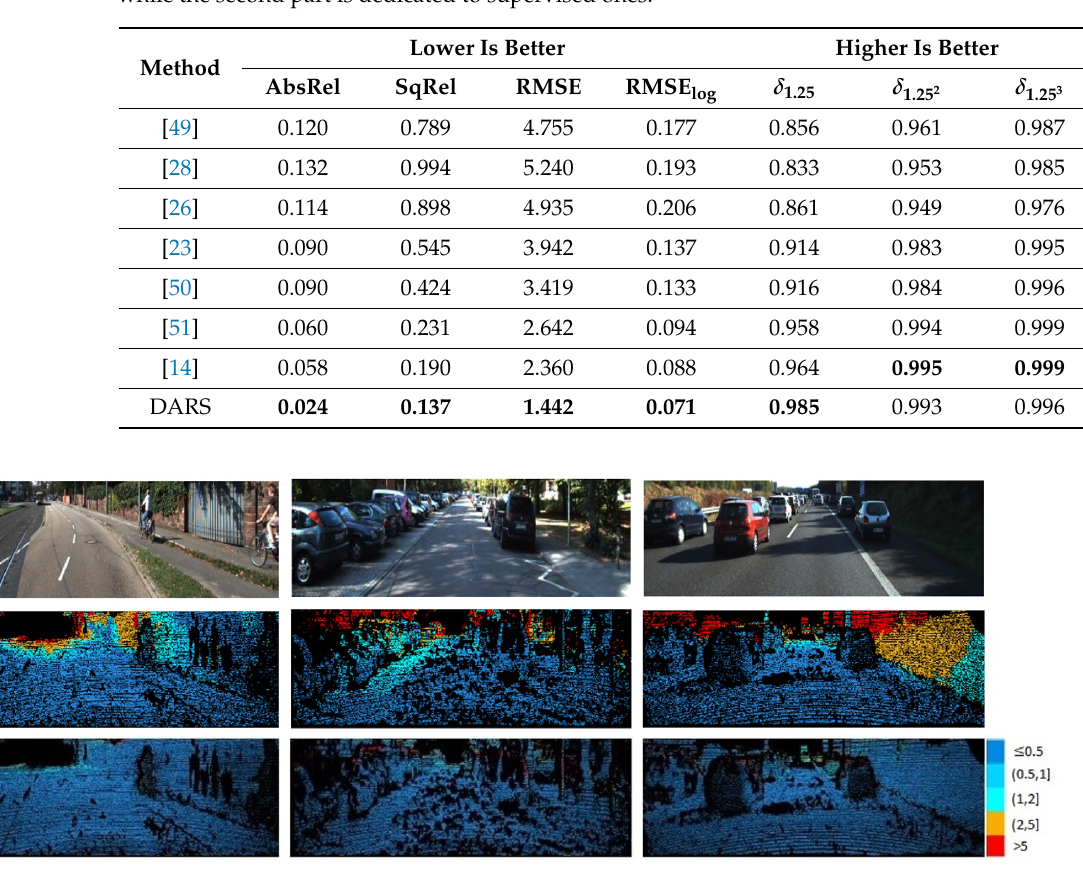
Figure 9. Visual results related to the comparative study of the KITTI dataset. The results of Adabins [14], as the second best method, are brought. Also, numbers on the right side of error patterns are in